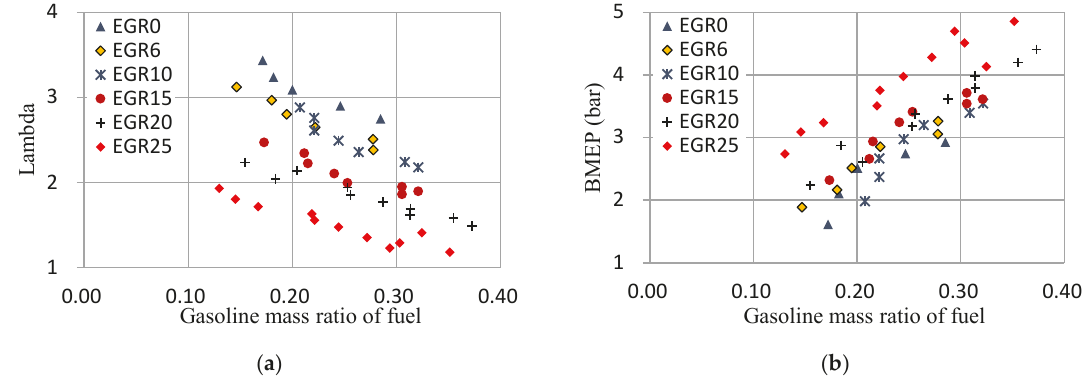
Figure 5. Effect of gasoline mass ratio in the dual-fuel on: ( a ) Lambda; ( b ) BMEP.